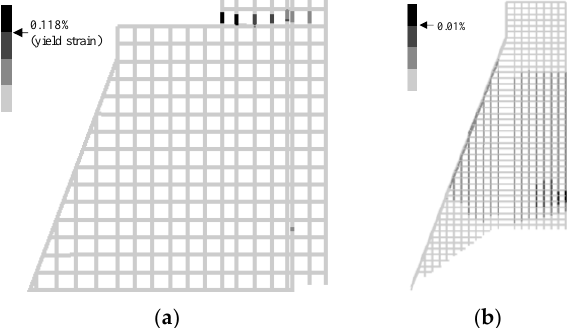
Figure 27. Strain distribution of the reinforcing bars (TYPE-A, wave A, reinforcing range 30%): ( a ) existing part: ( b ) reinforcement